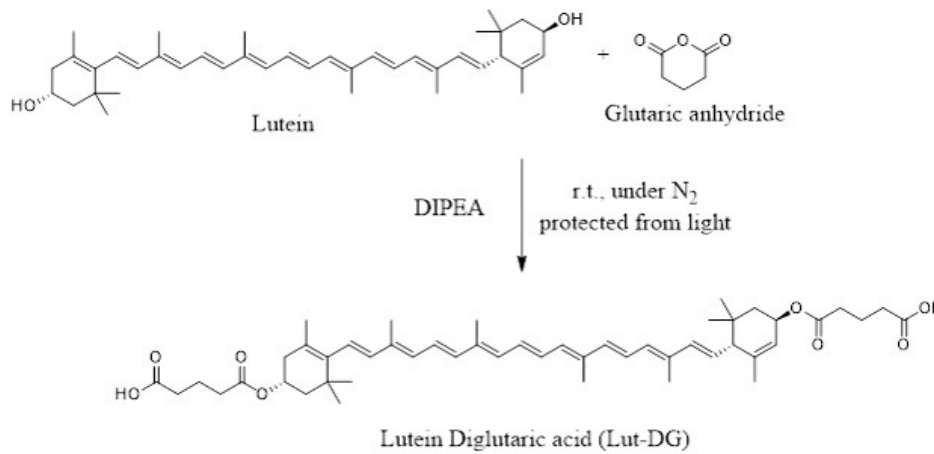
Figure 8. Schematic of the Lutein conjugation reaction with glutaric acid.